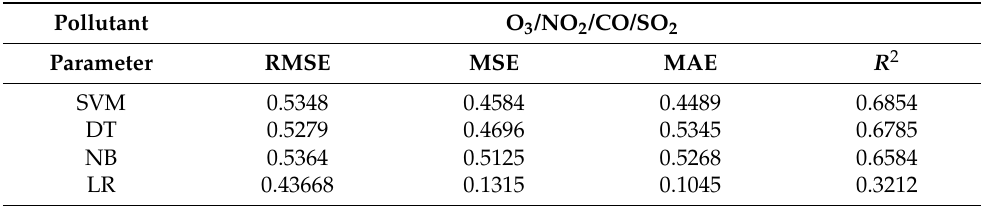
Table 6. Error comparison for O 3 /NO 2 /CO/SO 2